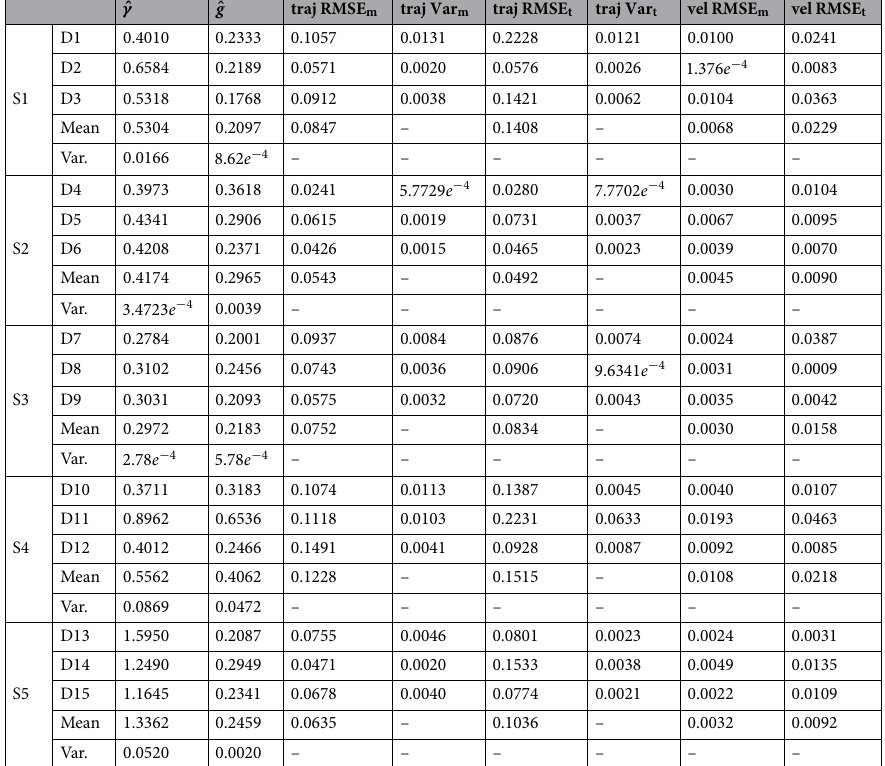
Table 1. Identified parameters and RMSE between the actual and simulated wand trajectory. S1–S5 represent the two human participants, while D1–D15 are the 15 datasets collected in the experiments. traj RMSE m shows the RMSE between the true and the simulated wand trajectory in the training set, and traj RMSE t presents the RMSE in the test set (in m). traj Var m and traj Var t are the variance of the difference between the true and the simulated wand trajectory, for the training set and the test set, respectively. Similarly, vel RMSE m and vel RMSE t shows the RMSE between the true and the simulated wand velocity, in the training set and the test set, respectively (in